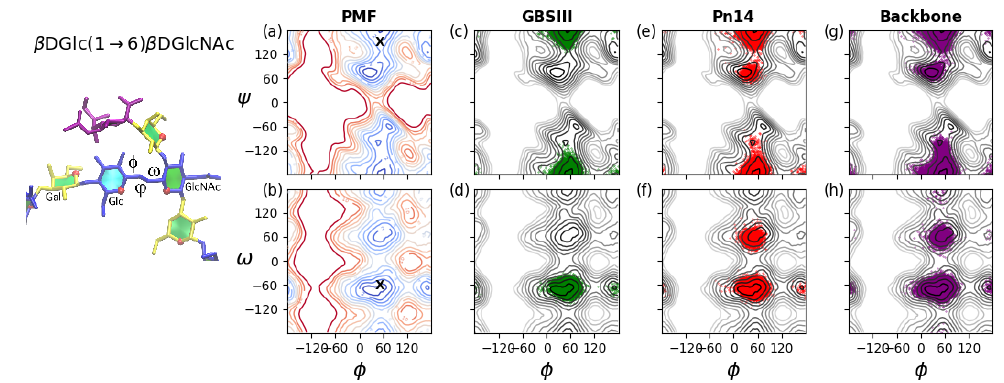
Figure 5. Rotation of the three-bond β D Glc(1 → 6) β D GlcNAc linkages in GBSIII, Pn14 and the unbranched backbone PS. The φ , ψ and ω angles describing the orientation of this linkage are labeled on the GBSIII fragment shown on the left. Contoured 2D ( a ) φ , ψ PMF and ( b ) the φ , ω PMF surfaces for a β D Glc(1 → 6) β D GlcNAc disaccharide in the gas phase illustrate the range of motion possible for an unrestrained linkage. Contours are drawn at intervals of 1 kcal · mol − 1 to a maximum of 12 kcal · mol − 1 and ‘X’ markers indicate dihedral angle values from the six-sugar GBSIII epitope identified in the DP2-Fab crystal structure [13]. The range of motion actually explored by the 6RU oligosaccharides is demonstrated with time series scatter plots of the two central β D Glc(1 → 6) β D GlcNAc linkages in the 6RU strands superimposed on the PMFs as follows: (c) GBSIII φ , ψ ; (d) GBSIII φ , ω ; (e) Pn14 φ , ψ ; (f) Pn14 φ , ω ; (g) unbranched backbone φ , ψ ; and (f) unbranched backbone φ , ω